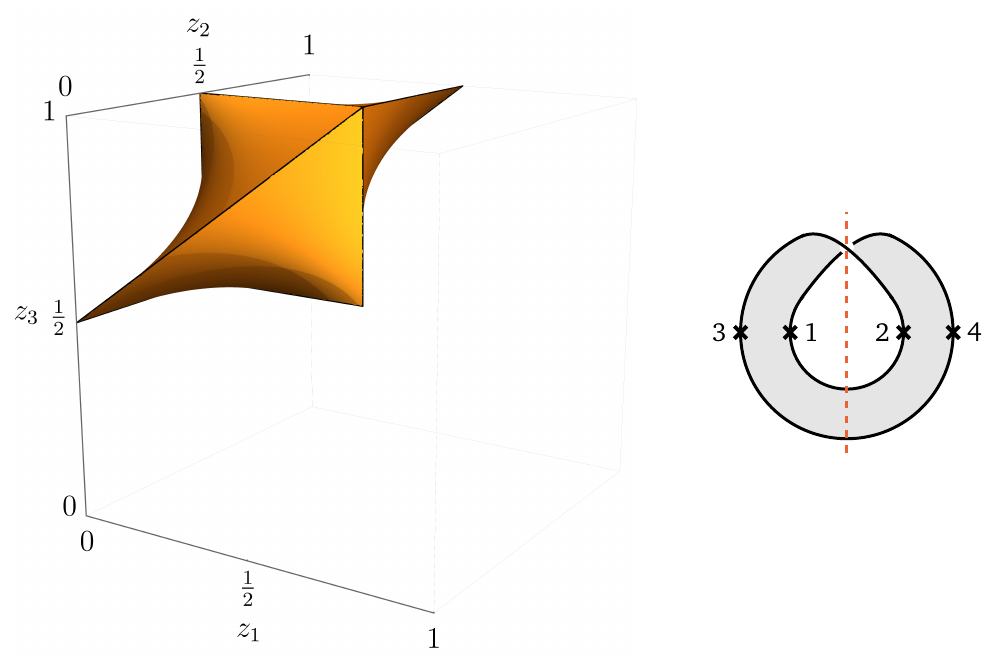
) -space where the exponent Trop < 0. The , z , z 1 2 3 and t = − 1 . Right: the corresponding unique unitarity 2 2